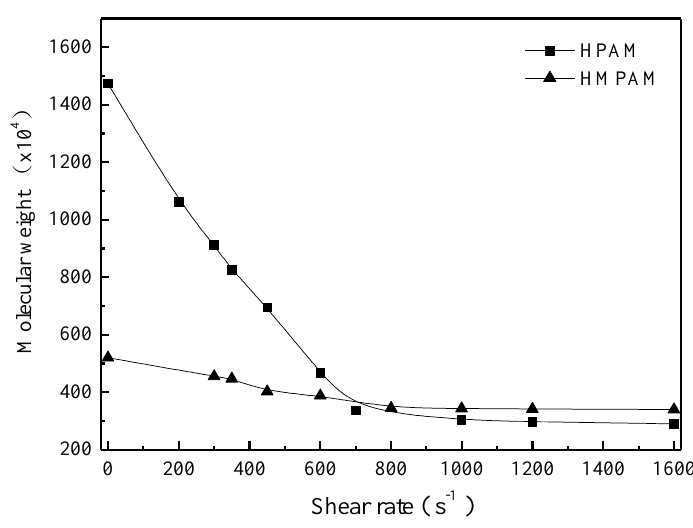
Figure 7. Molecular weight of polymers versus shear rate at 45 °C.